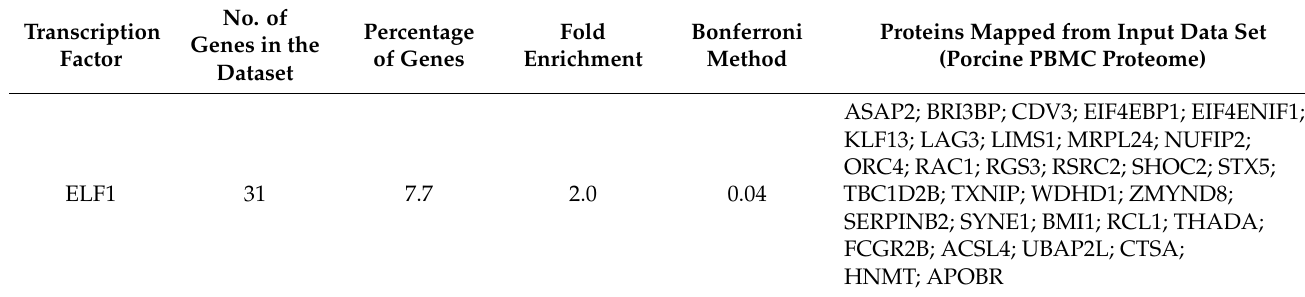
Table 2. Significantly enriched transcription factor in BanLec stimulated porcine